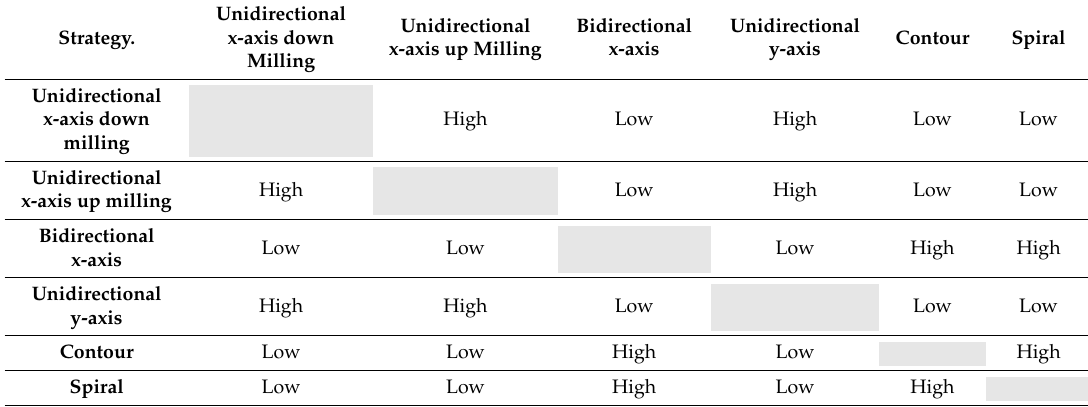
Table 2. A similarity matrix of energy patterns in 2.5 dimensional pocketing strategies. Strategy.